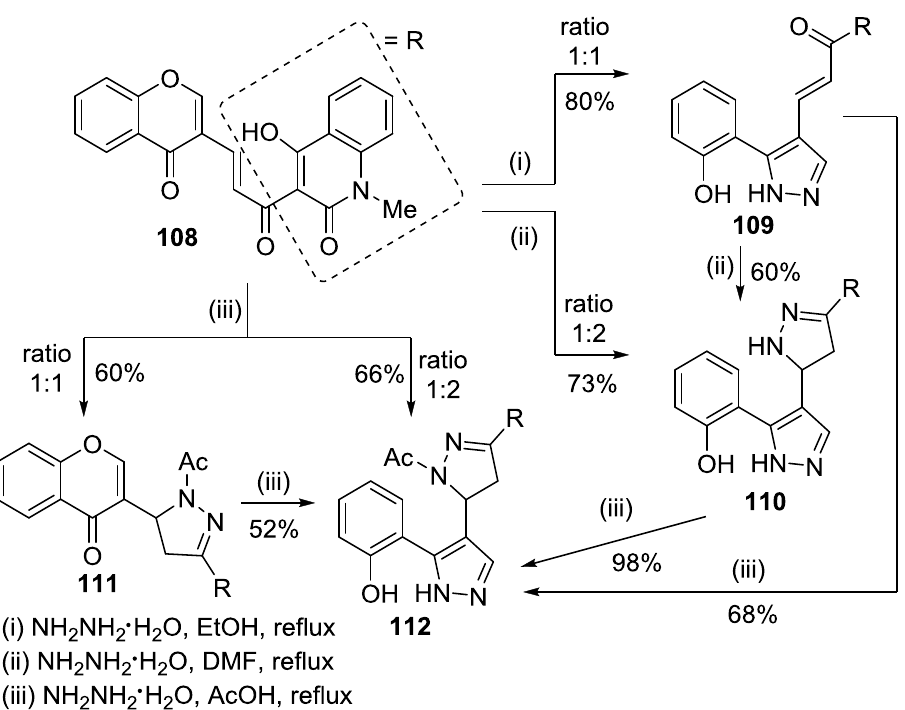
Scheme 37. Reaction of 4-hydroxy-1-methyl-3-[( E )-3-(chromen-3-yl)acryloyl]quinolin-2(1 H )-one